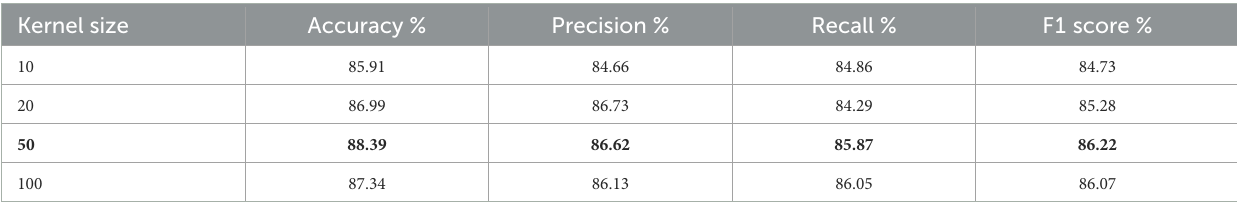
TABLE 1 Average performance results based on differences in the size of the convolution kernel for 1D convolution in the Fourier transform. Kernel size